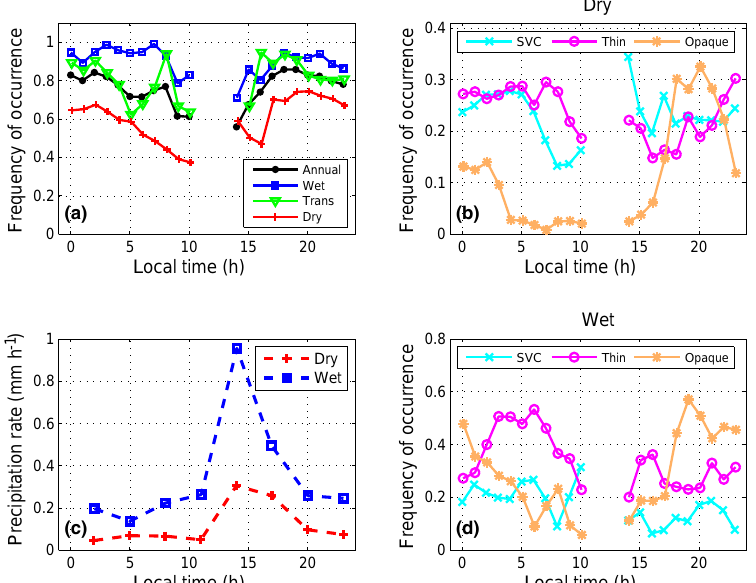
Figure 4. Panel (a) shows the daily cycles of the hourly frequency of occurrence of cirrus clouds for the annual, wet, transition, and dry periods. The same is shown for SVC, thin, and opaque cirrus clouds during the dry (b) and wet (d) seasons. Mean observed precipitation rate (mmh − 1 ) from TRMM version 7 over an area of 2 ◦ × 2 ◦ centered on the site, for the dry and wet periods, is given in (c) .